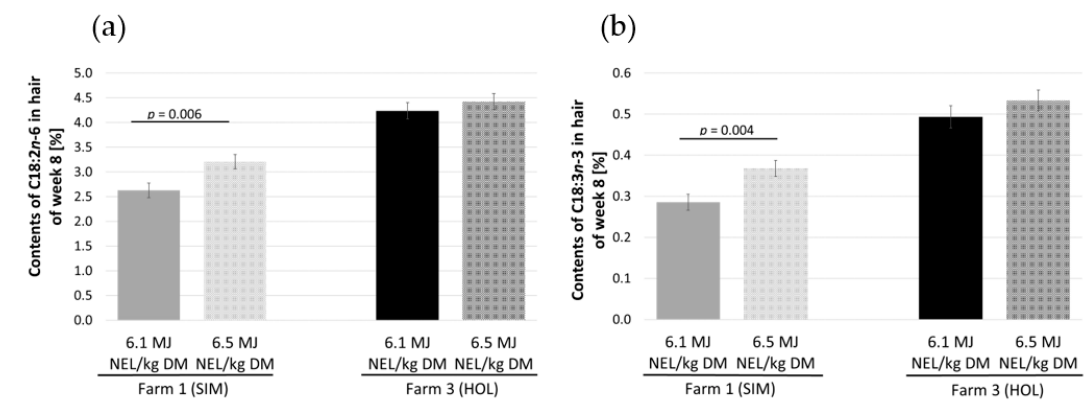
1 Values in the feeding group provide the energy concentration of roughage (6.1 or 6.5 MJ NE the amount of concentrate supply (150 or 250 g/kg ECM). In farm 2 (SIM) only one energy concentration of the roughage was provided (6.5 MJ NEL/kg DM). + standard error of the mean, MJ—megajoule, NE L —net energy for lactation, BW—body weight. Non-significant p -values > 0.05 of interaction terms are not shown (e.g., × R × C × Week in all three farms, R × C in farm 1).